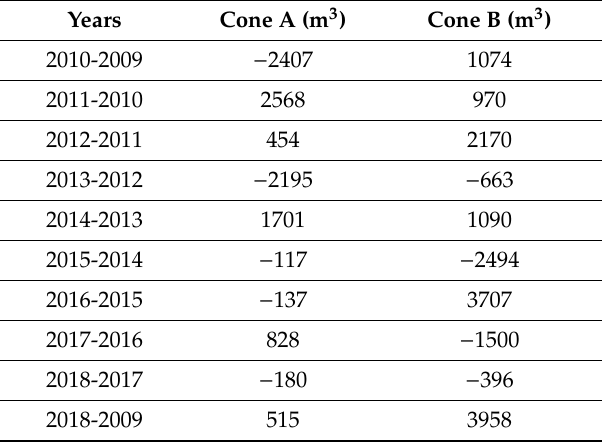
Table 2. Annual and total changes (2018–2009) in volume in debris cones A and